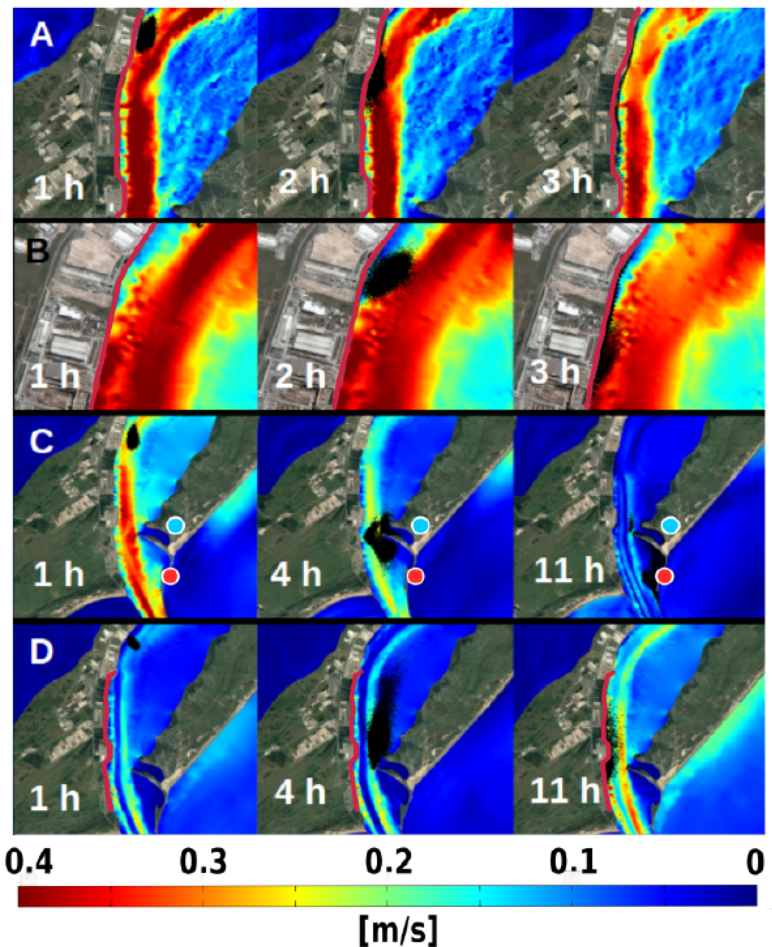
Figure 3. Simulation results of oil spill on ebb conductions ( A – D ). The oil (black dots) is advected seaward in all events. The color scale shows the current magnitude (ms − 1 ), higher in the channel of the